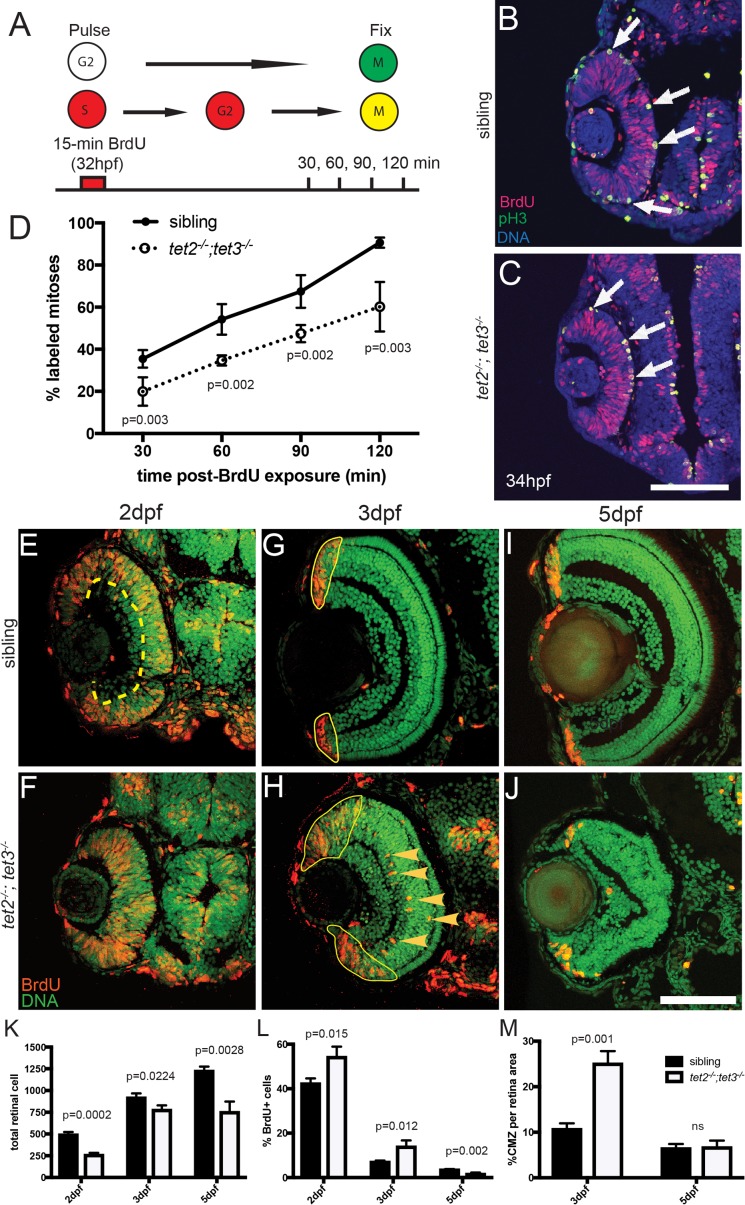
RPC cell cycle dynamics are disrupted in tet2-/-;tet3-/-.A) Percent labeled mitoses (PLM) assay was performed by treating embryos for 15 minutes in bromodeoxyuridine (BrdU) pulse at 32hpf, rinsed, fixed at 30, 60, 90, and 120 minutes post-treatment for immunostaining. (B,C) Cells in S-phase during BrdU pulse (BrdU+; red) and cells in G2/M-phase at fixation (pH3+; green) were counted. Cells that were proliferative during the BrdU pulse and then undergo mitosis are double positive (BrdU+,pH3+; yellow; arrows). (D) tet2-/-;tet3-/- retinae show significantly lower proportion of labeled mitotic events ([BrdU+pH3+]/pH3+) at all four time points. By the end of 120-minute window, nearly all ‘labeled’ RPCs completed S to M phase transition in wild-type siblings, compared to only 50% in tet2-/-;tet3-/- mutants (n = 5 embryos per condition per timepoint analyzed). (E-M) At later time points, BrdU incorporation assays over 2-hour time windows revealed that retinal progenitor cells remain proliferative longer and proliferate ectopically in tet2-/-;tet3-/- mutants. (E,F) At 2dpf, cells within the central retina of wild-type sibling embryos (dotted line) are no longer proliferative, correlating with cell cycle exit and differentiation. (G,H) At 3dpf, the only proliferative cells in the wild-type retina are located in the CMZ (outlined). In tet2-/-;tet3-/- mutants, this proliferative region is significantly expanded. Ectopically proliferating cells are also observed outside of the CMZ at significantly higher numbers than wild-type siblings (arrowheads). (I,J) At 5dpf, both sibling and tet2-/-;tet3-/- eyes possess proliferative CMZs. (K) Total retinal cell count per section is significantly lower in tet2-/-;tet3-/- mutants compared to siblings at all time points, correlating with microphthalmia. (L) tet2-/-;tet3-/- mutant retinae possess a significantly higher percentage of proliferative (BrdU+) cells at 2 and 3dpf, but lower at 5dpf. (M) Percentage of CMZ area per total retina is significantly higher in tet2-/-;tet3-/- mutant at 3dpf, but not significantly different at 5dpf. N = 3 embryos per condition per time point for E-M. Dorsal is up and anterior to the left in all images. All error bars = ± 1 S.D. All p-values calculated using two-tailed, unpaired t-test. Scale bar = 50μm in B-C; 80μm in E-J.